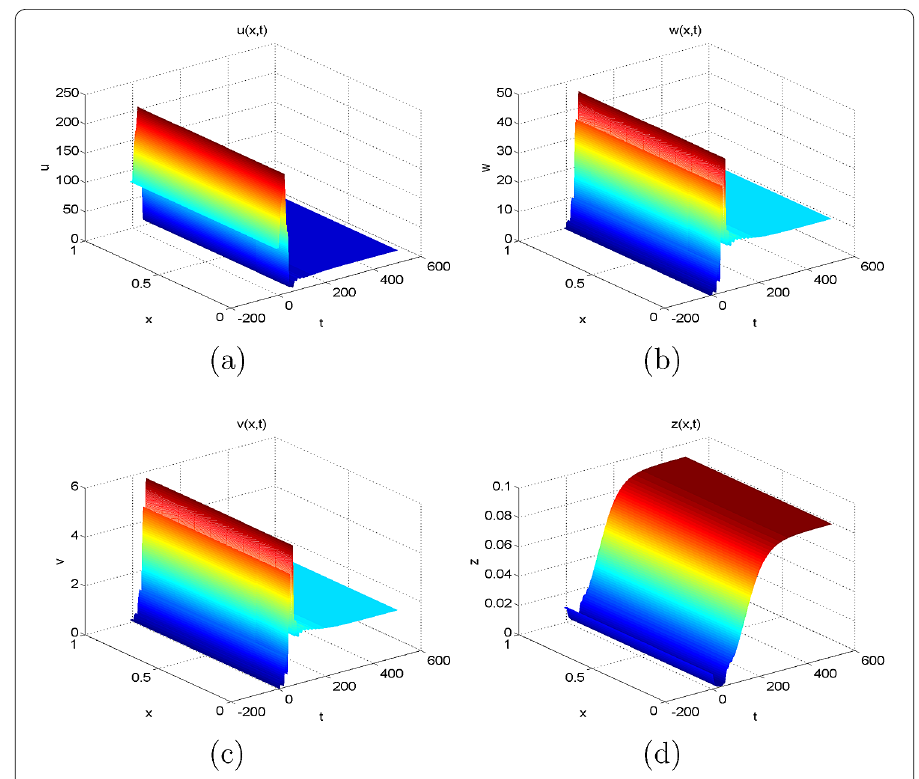
Figure 3 Taking β = 0.3, c = 0.01, q = 0.15, τ 1 = 10, τ 2 = 5, we have R 0 = 6.2597 > 1, R 1 = 1.2303 > 1, the infection equilibrium only with CTL immune response E 2 (10.9402,15,1.7214,0.1272) is globally asymptotically